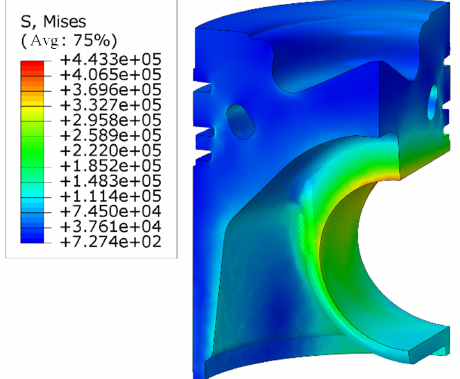
Fig. 10. Thermal-mechanical coupling stress distribution of uncoated pistons